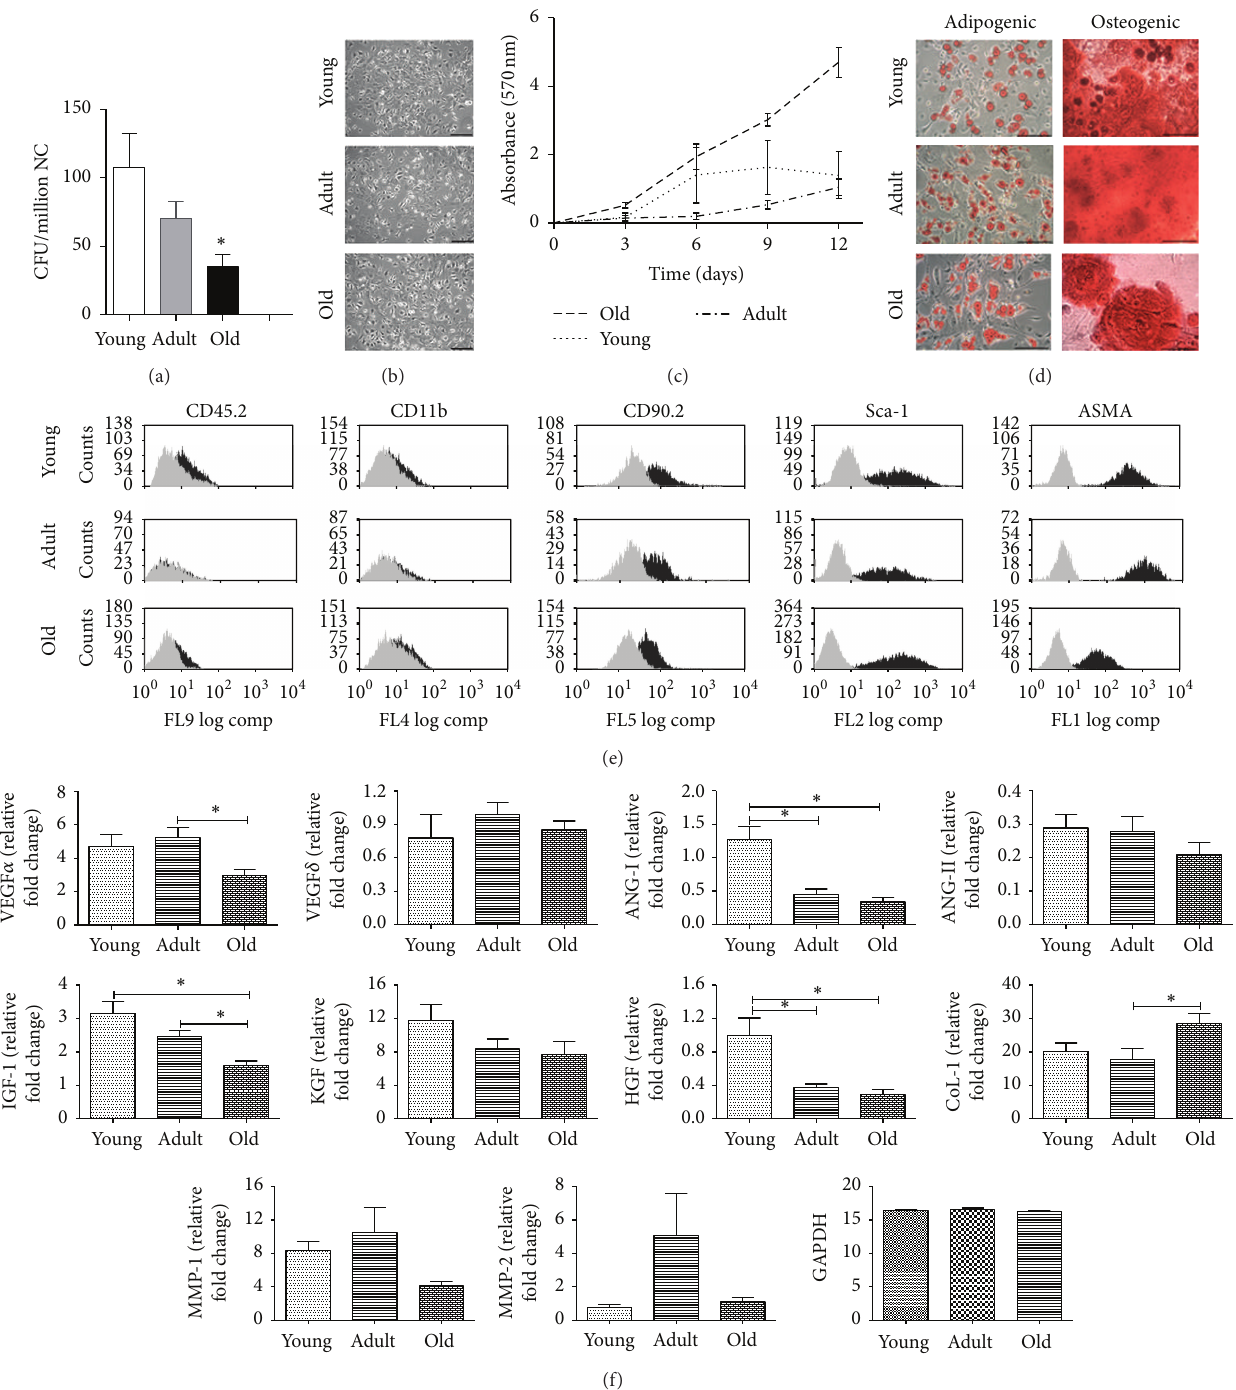
Figure 4: Characterization of isolated BM-MSCs from different aged C57BL/6 mice. (a) Bone marrow abundance was determined by CFU assay. Data are mean ± SEM ( 𝑛 = 6 ). ANOVA ∗ : young versus old. (b) Morphology from MSC derived from different age groups. Scale bar 100 𝜇 m. (c) Proliferation kinetics was evaluated by crystal violet staining (570 nm absorbance) over a period of 12 days. Data are mean ± SEM ( 𝑛 = 4 ). (d) Differentiation potential was assessed by in vitro exposure to adipogenic or osteogenic medium and stained with Oil Red and Alizarin Red after 21 days, respectively. (e) Flow cytometry was used for the assessment of MSC surface markers. MSCs expressed anti- CD90.2, anti-Sca-1, and anti-ASMA antibodies but not anti-CD45.2 and anti-CD11b antibodies. Representative images for 2 animals per each age group. Representative images from 3 animals per each age group. Scale bar 100 𝜇 m. (f) The mRNA profiles of MSC paracrine factors (VEGF 𝛼 , VEGF 𝛿 , ANG-I, ANG-II, IGF-1, KGF, HGF, CoL-1, MMP-1, and MMP-2) from different aged donors were analyzed by RT-PCR and normalized by their relative ratio to GAPDH. Data are mean ± SEM ( 𝑛 = 8 ). GAPDH, glyceral-dehyde-3-phosphate dehydrogenase. ∗ 𝑝 < 0.05